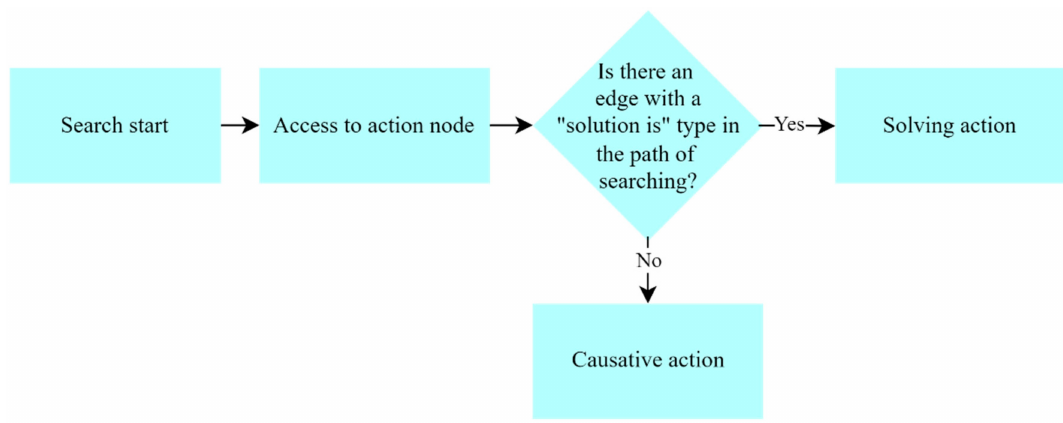
Figure 7. Schematic diagram of the action node